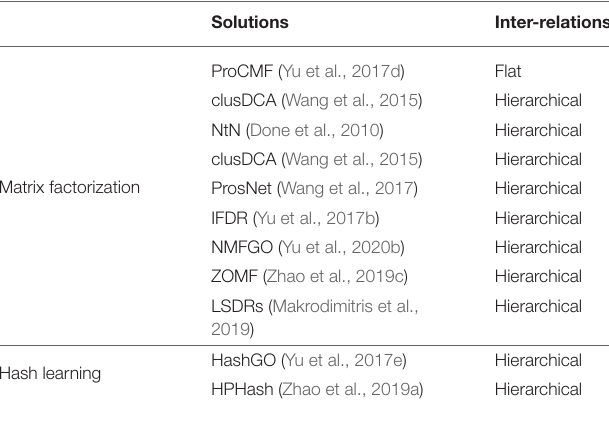
TABLE 2 | Exemplar solutions based on compressing GO